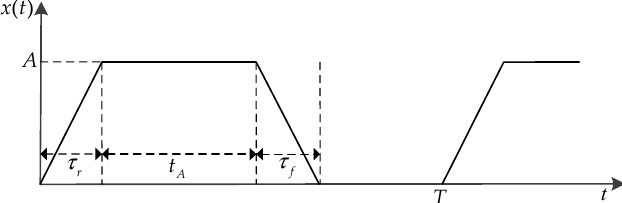
Figure 5. The periodic trapezoidal signal and its time domain parameters.